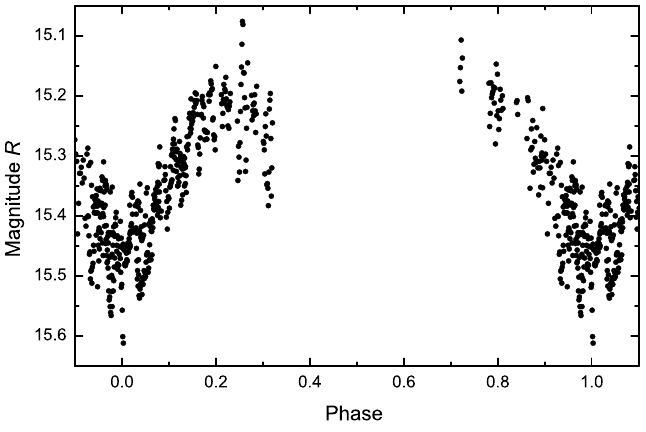
Fig. 7. The light curve of 2008 OS9 calculated with a period of 8.430